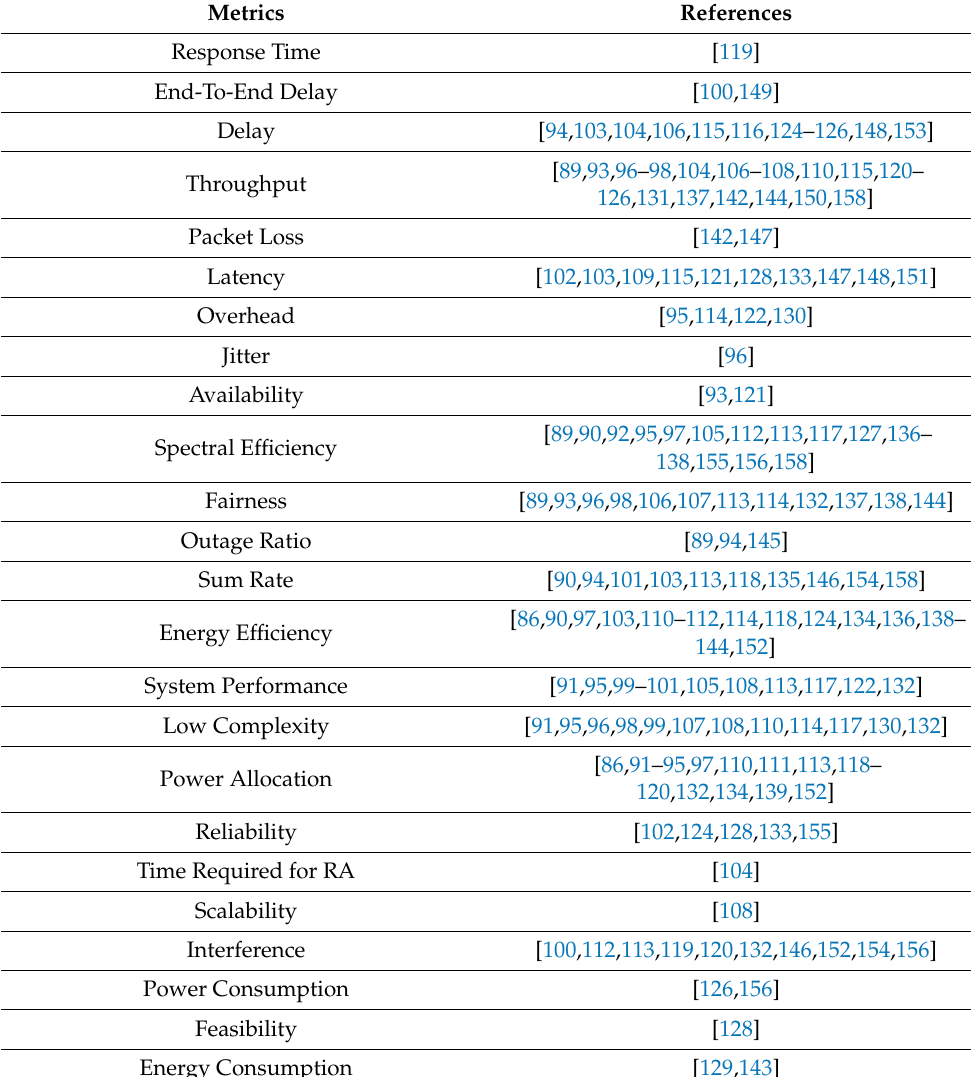
Table 5. Metrics used in 5G Resource